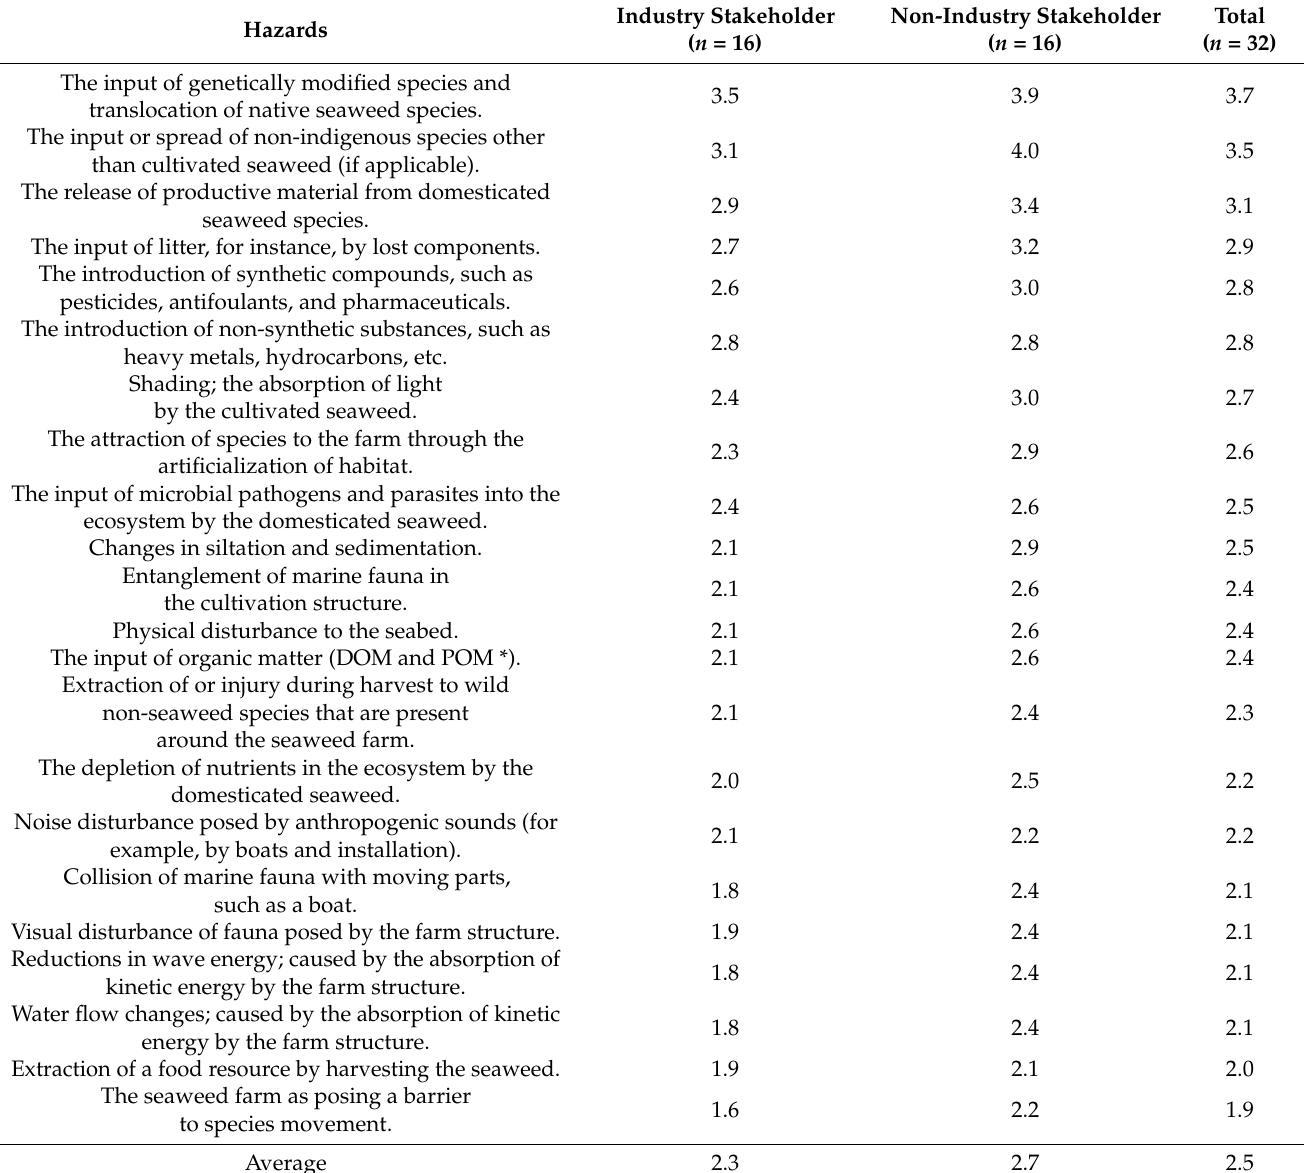
Table 2. Survey scores regarding the risks for 22 environmental safety hazards in seaweed with 5: biggest risk and 1: smallest